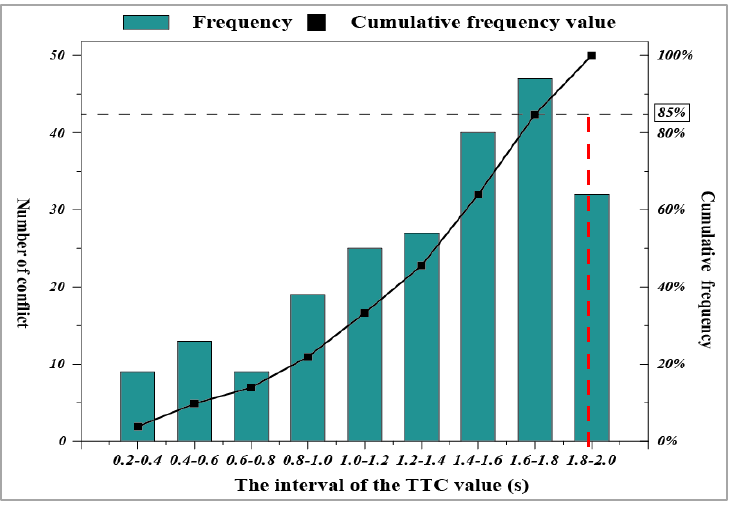
Figure 8. Cumulative frequency distribution of serious conflicts.